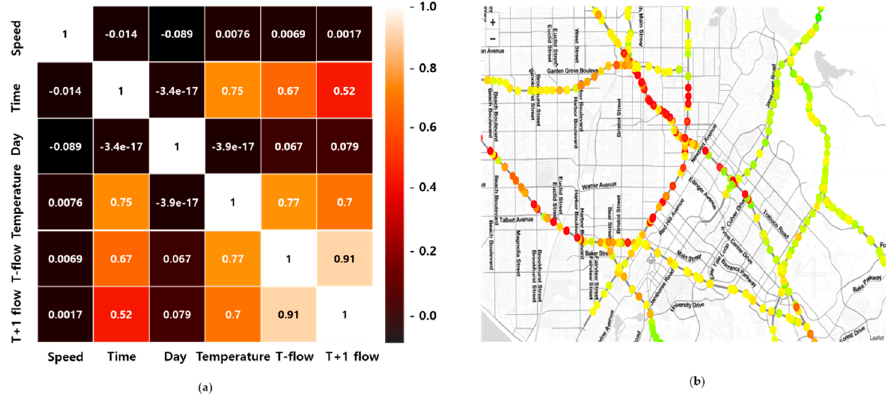
Figure 4. ( a ) Correlation matrix and ( b ) Visualized results of traffic flow prediction.